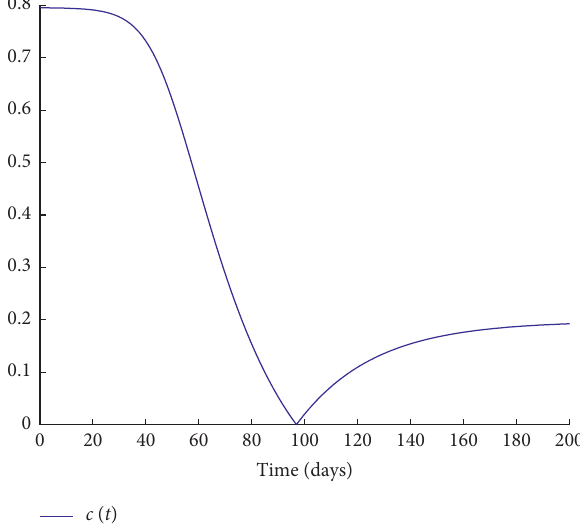
Figure 5: Evolution of the carrying capacity, c(t), parameterizing the time-varying logistic